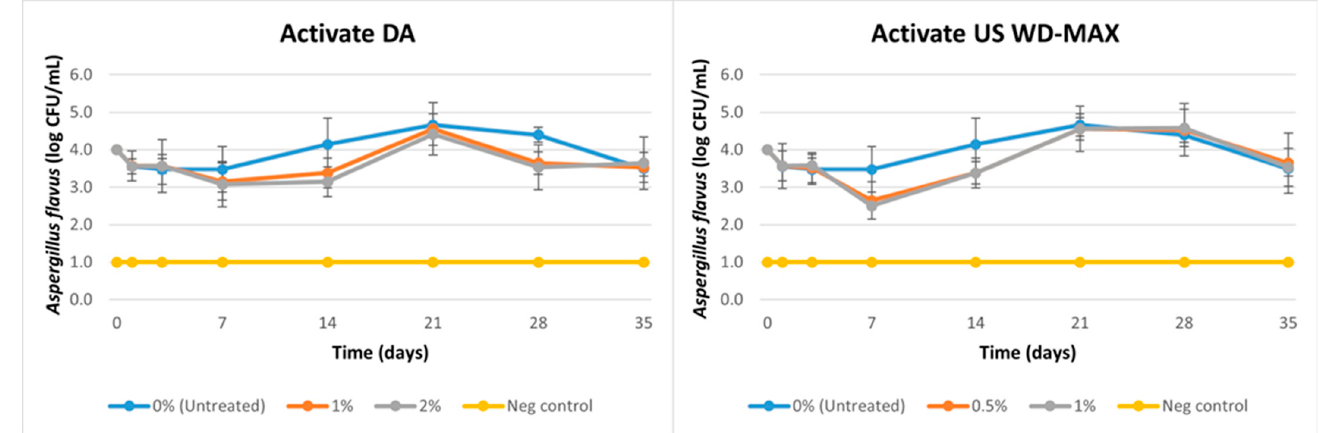
Figure 4. Mean logarithmic counts (log CFU/mL) of A. flavus in pet food kibble treatments with inclusion of organic acid mixtures Activate DA at 1% and 2% and Activate US WD-MAX at 0.5% and 1% concentrations as coating in comparison with untreated (0% organic acid). Furthermore, 0 h denotes initial load of A. flavus in inoculum before inoculation to the kibble. A negative con- trol consisted of canola oil-coated kibble (no organic acid, no inoculation). Limit of detection is 1 log CFU/mL for this study. Table 5. Mean logarithmic reduction of Aspergillus flavus counts in pet food kibble treatments with inclusion of organic acid mixtures Activate DA at 1% and 2% and Activate US WD-MAX at 0.5% and 1% concentrations as coating, in comparison with untreated (0% organic acid). The logarithmic reductions were calculated as the difference between A. flavus counts in the inoculum (4 log CFU/mL) and on the kibbles (untreated and treated). A negative control consisted of canola oil-coated kibble (no organic acid, no